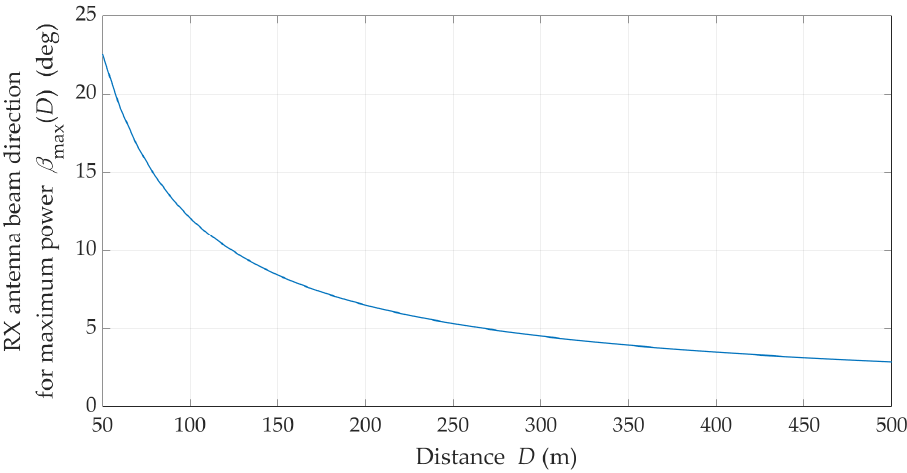
Figure 13. Statistical value of β max versus TX–RX distance under NLOS conditions.